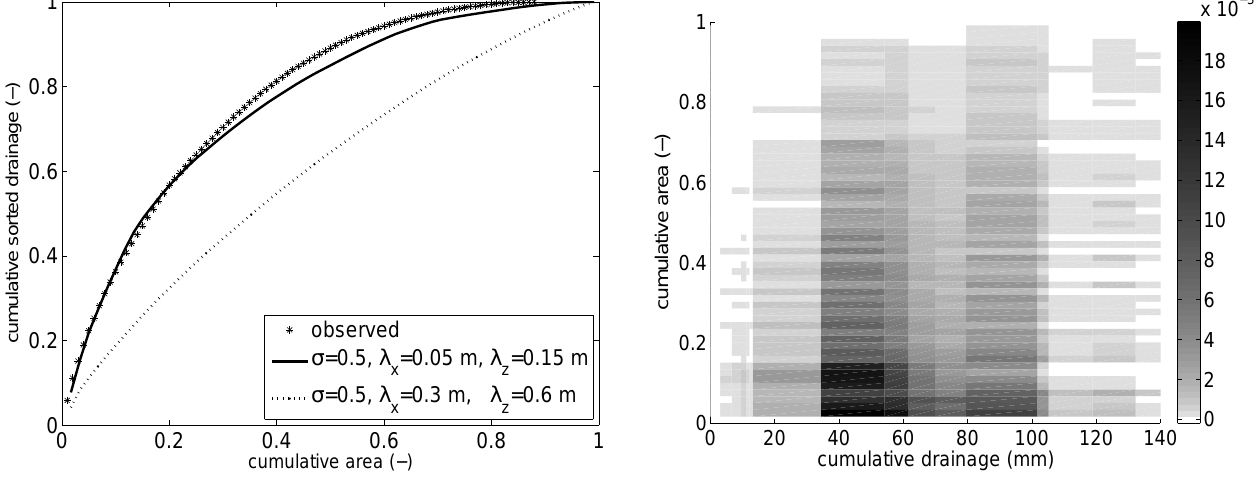
Fig. 7. Scaled solute flux density (d − 1 ) for tracer, at 0.5 m depth, for the simulated year 2010.